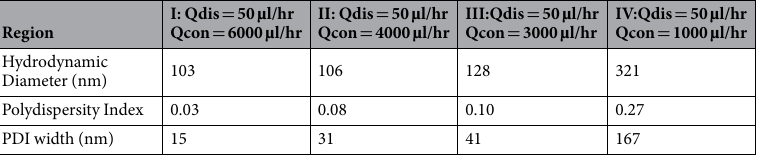
central jetting zone. Without sticking, and still flowing (Fig. 3d), these microdroplets finally shrunk into invis- ible nanoparticles under an optical microscope (Fig. 3e), yet they were detectable using DLS techniques. In the